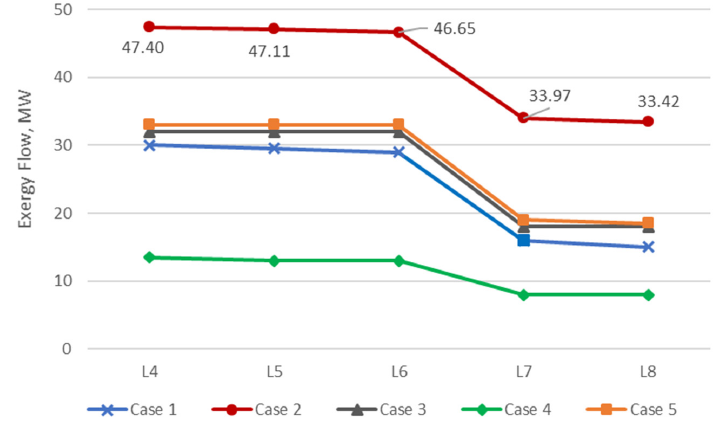
Figure 2. Composition of the LNG exergy flow in regasification system: L4, LNG flow transfer to LNG booster pump; L5, LNG input to BOG recondenser; L6, LNG output from BOG recondenser and input to LNG vaporiser; L7, NG flow from LNG vaporiser and input to NG trim heater; L8, NG flow from NG trim heater to natural metering system.